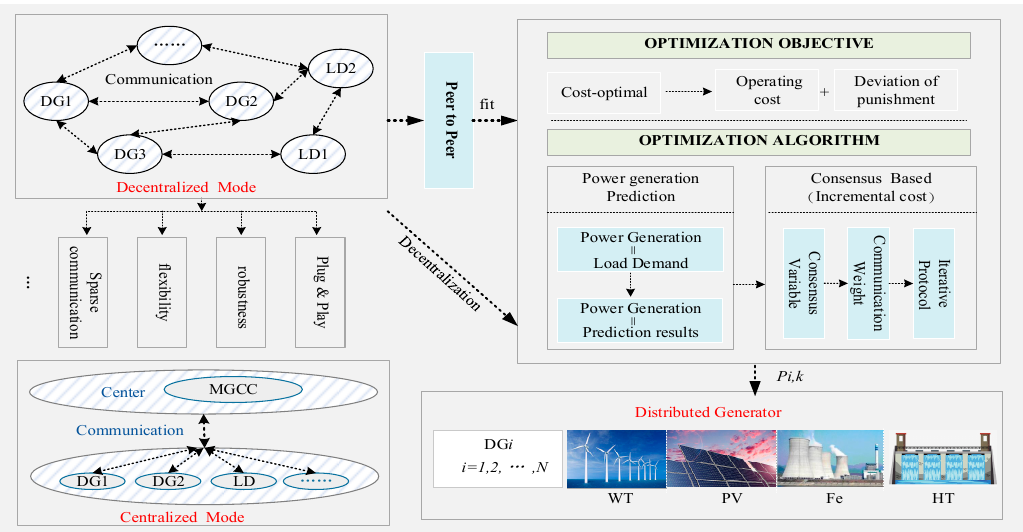
Figure 1. Structure of the microgrid system and optimization strategy.